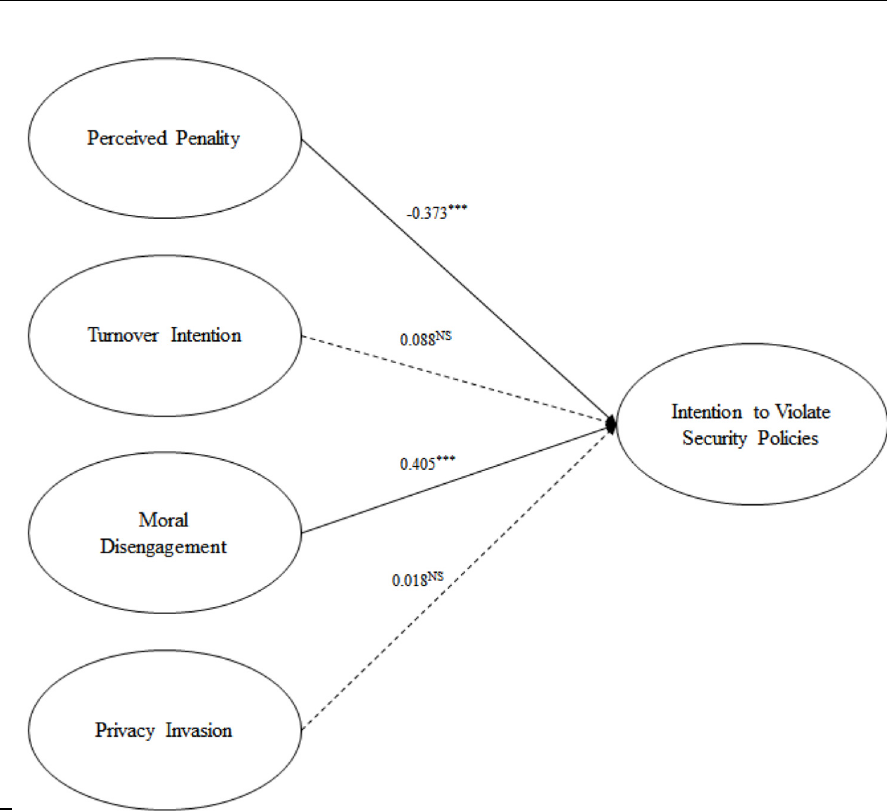
Figure 1. Empirical